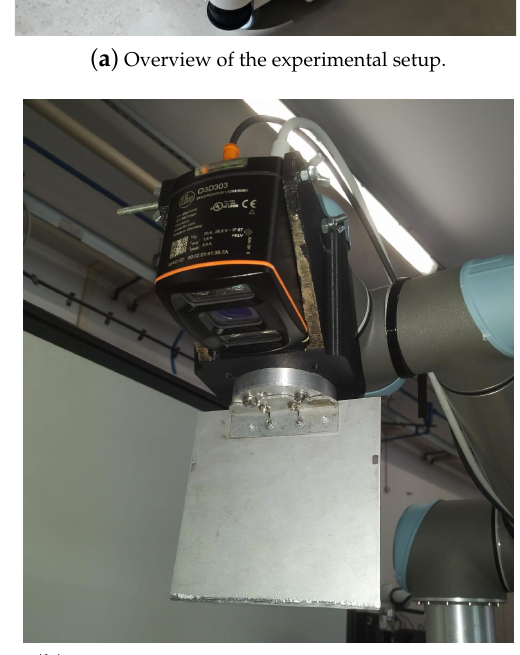
Figure 5. The experimental setup: the mobile manipulator ( a ), the paddle tool and the in-hand 3D camera ( b